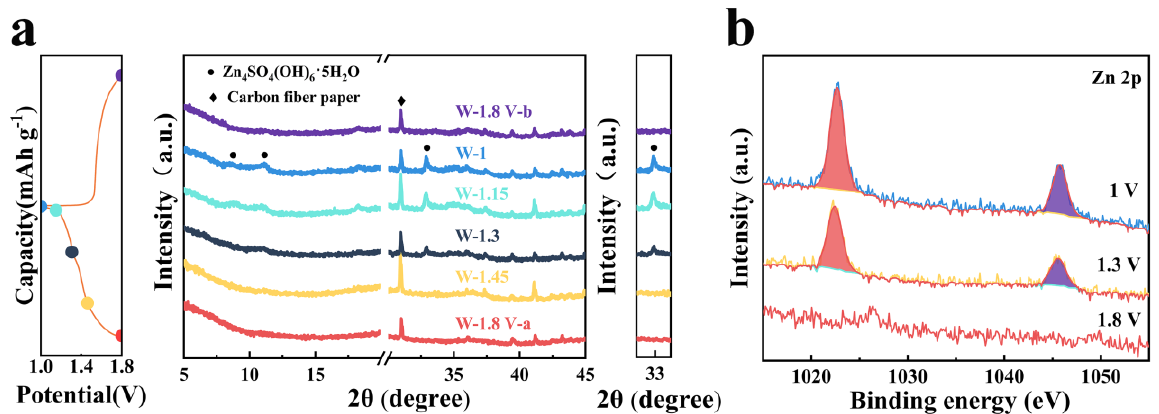
Figure 3. ( a ) Ex situ XRD analysis of W-MnO 2 cathode at various voltages. ( b ) XPS spectra of Zn 2p at different discharge stages. at different discharge